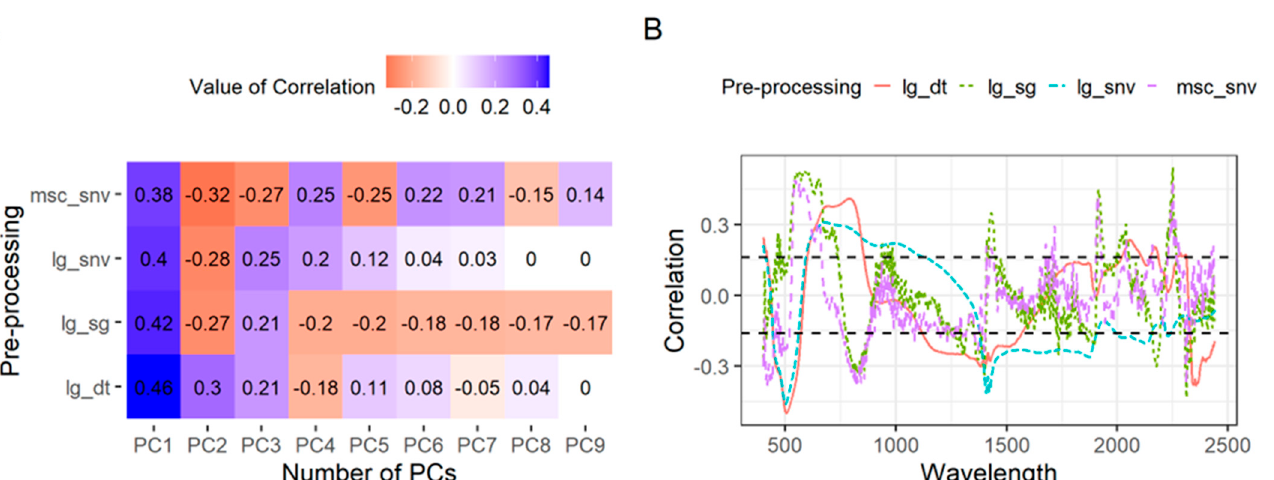
preprocessing methods ( B ). Note: lg_sg: Savitzky-Golay of log(1/(R)), lg_snv: standardNormalVari-